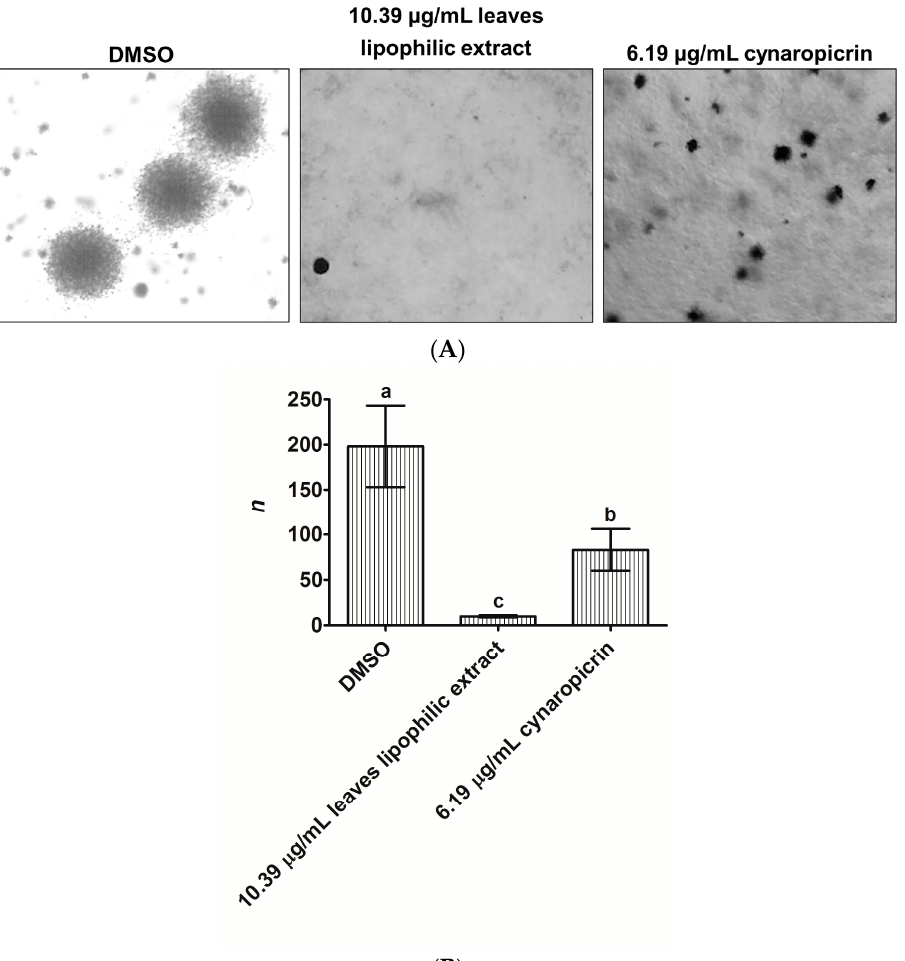
Figure 2. Effect of 10.39 µg/mL cultivated cardoon leaves lipophilic extract and 6.19 µg/mL cynaropicrin, against MDA-MB-231 cells colonies formation, via an anchorage-independent growth assay, after 14 days. DMSO (0.09% ( v / v )) was used as solvent control. ( A ) Representative photographs of colonies (40× magnification); ( B ) Number of colonies ( n ). Each column and bar represents the mean and the standard deviation, respectively. Triplicates were carried out. Columns with different letters are statistically different ( p < 0.05).